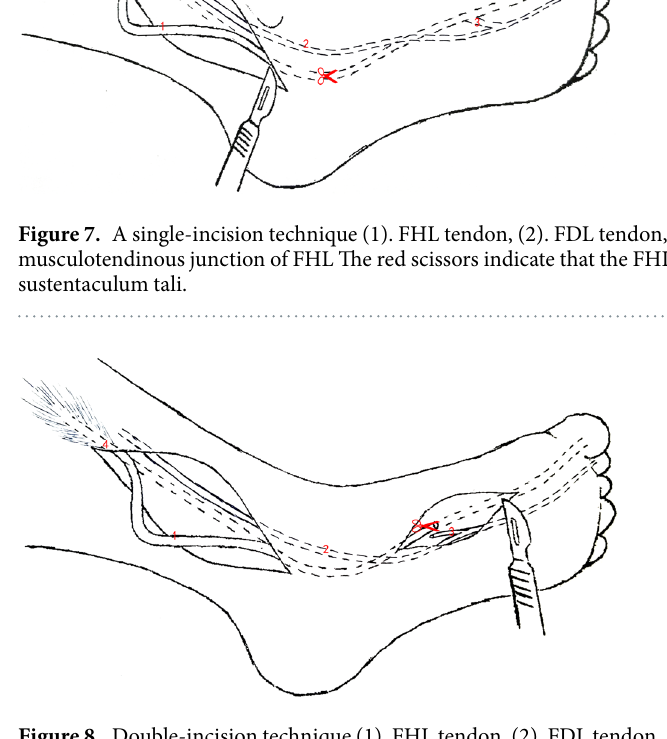
Figure 8. Double-incision technique (1). FHL tendon, (2). FDL tendon, (3). tendinous slip, (4). musculotendinous junction of FHLThe red scissors indicate that the FHL tendon was cut at the level of Henry’s knot.